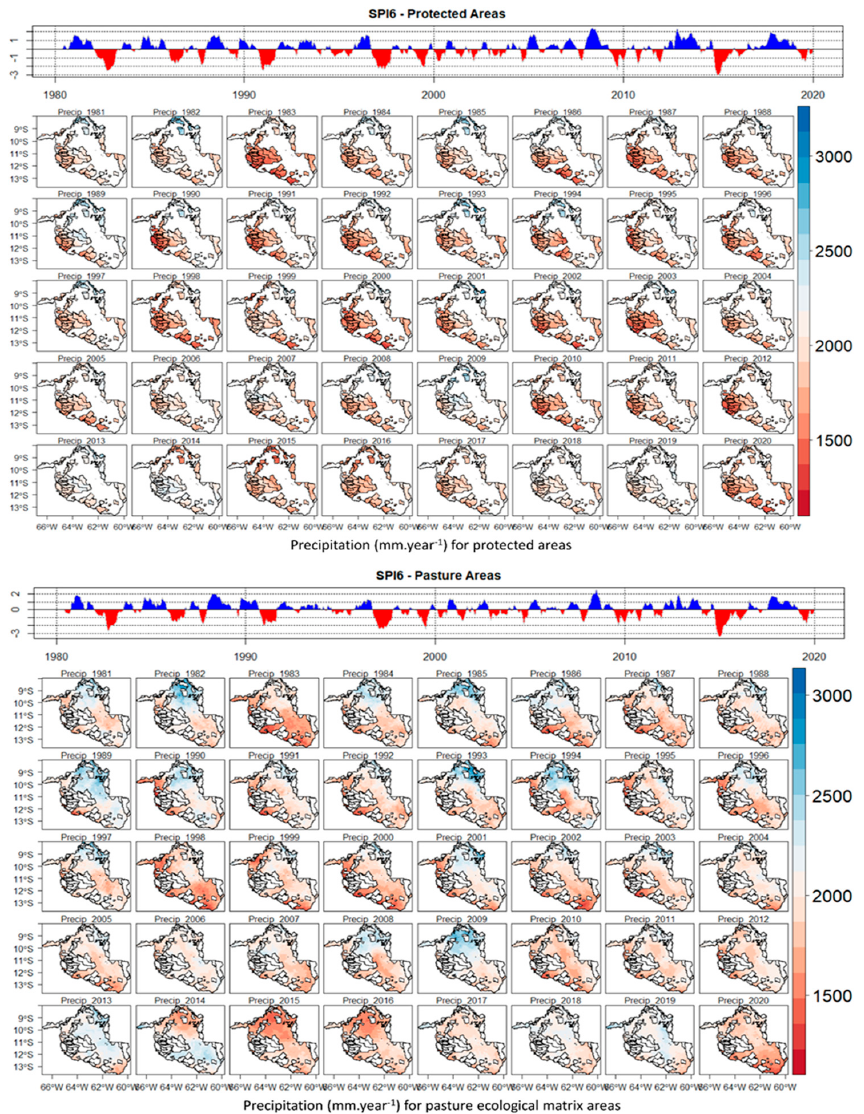
Figure 5. Precipitation Spatial distribution (mm.year − 1 ) and SPI–6 for protected areas and pasturelands in the State of Rondônia from 1981 to 2020 using CHIRPS data.